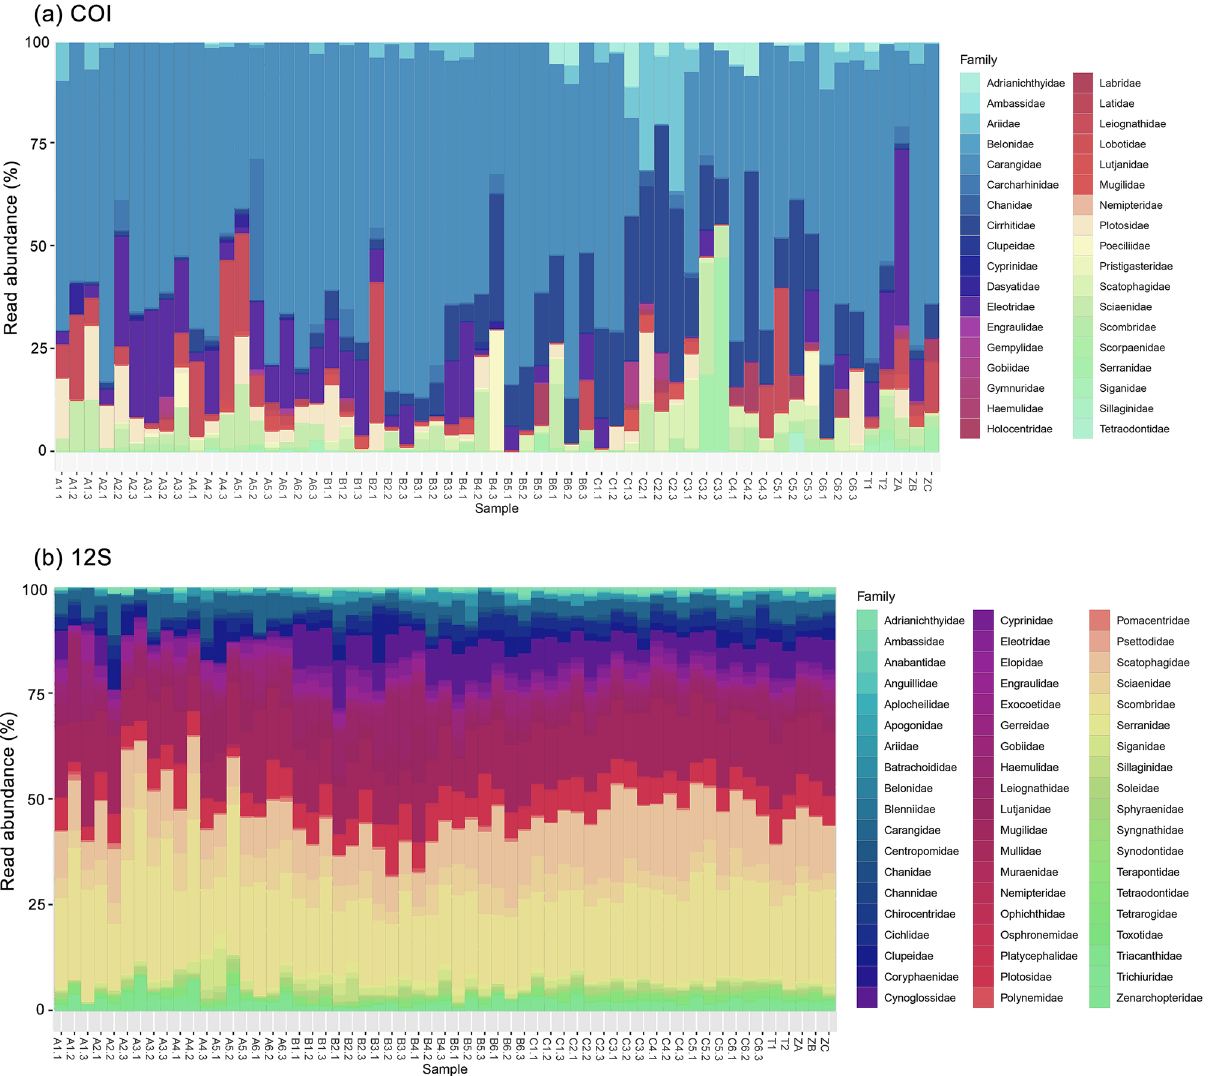
Figure 4. Barplots showing relative read abundance in all samples per fish family; ( a ) COI assay and ( b ) 12S